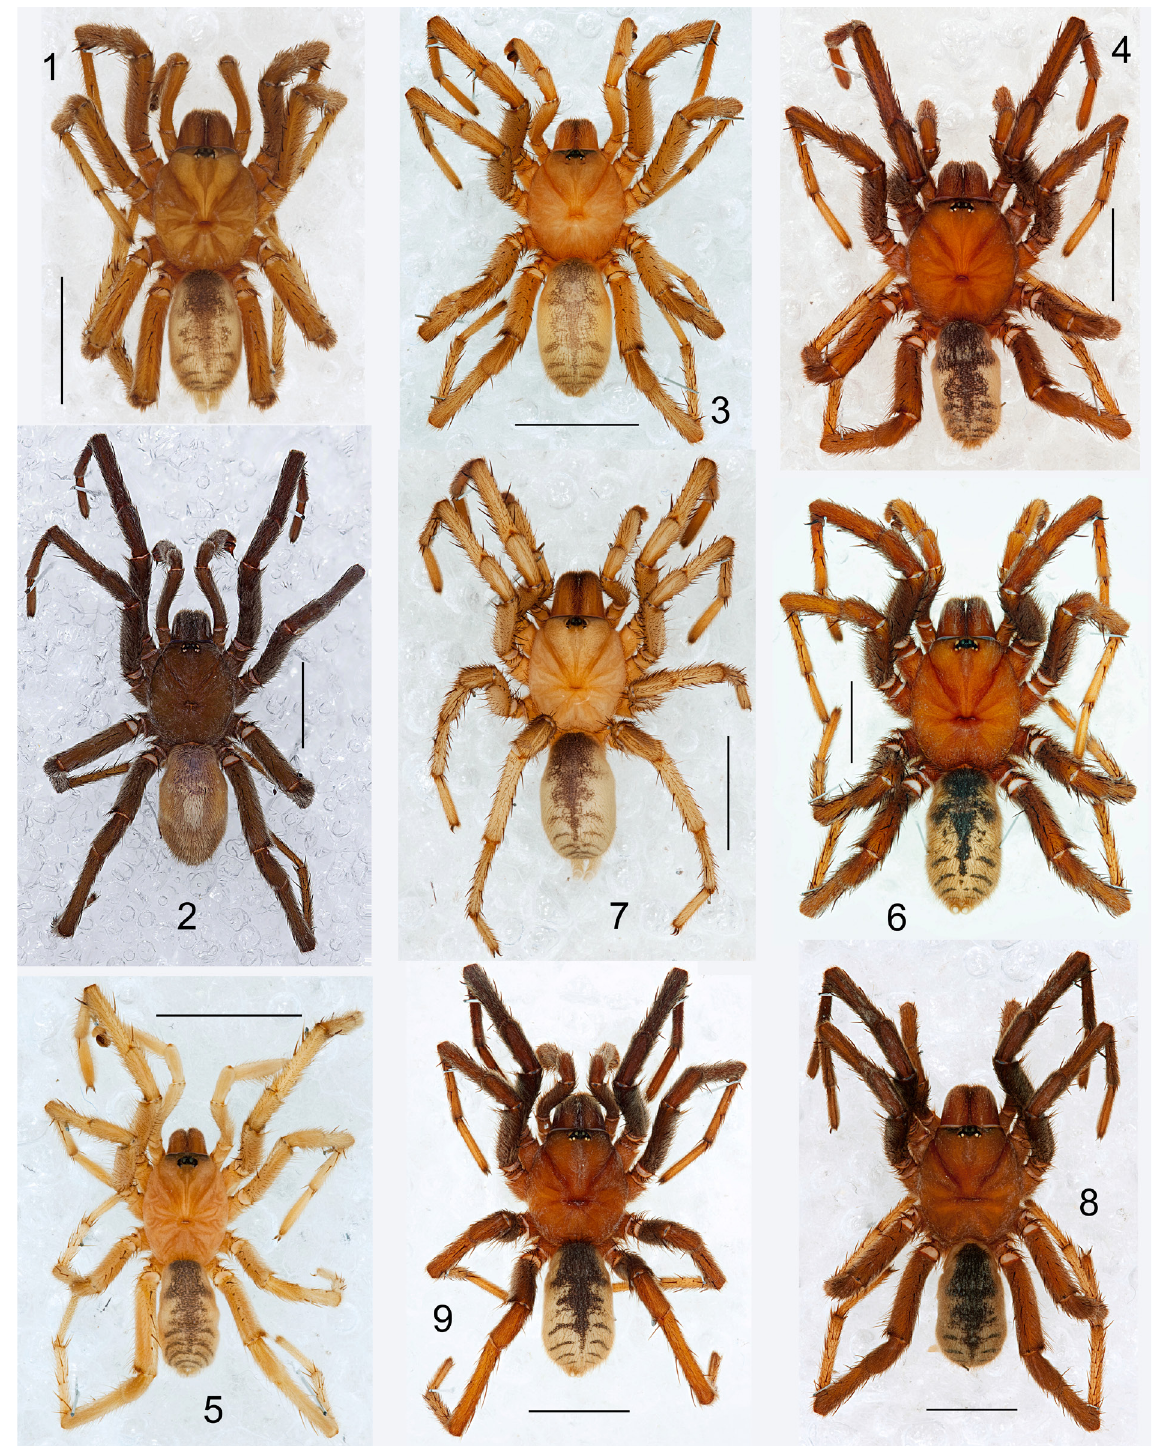
Figs 1–9. Anemesia spp., ♂♂, habitus, dorsal views. 1 . A. birulai (Spassky, 1937). 2 . A. koponeni Marusik, Zamani & Mirshamsi, 2014. 3 . A. pococki sp. nov. 4 . A. tubifex (Pocock, 1889). 5 . A.